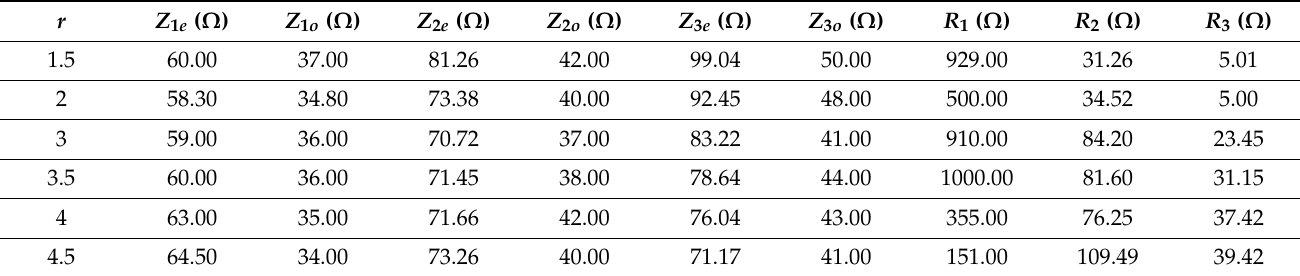
Table 2. Circuit Parameters with the variation of r.